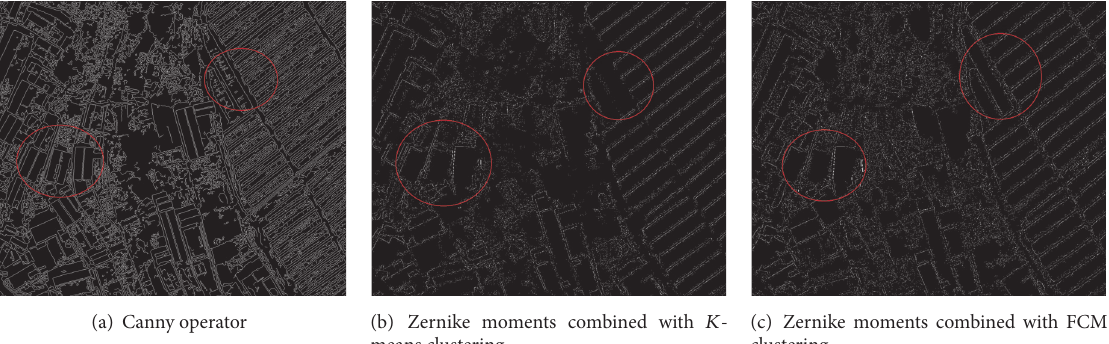
Figure 7: The results of second experiment for Data